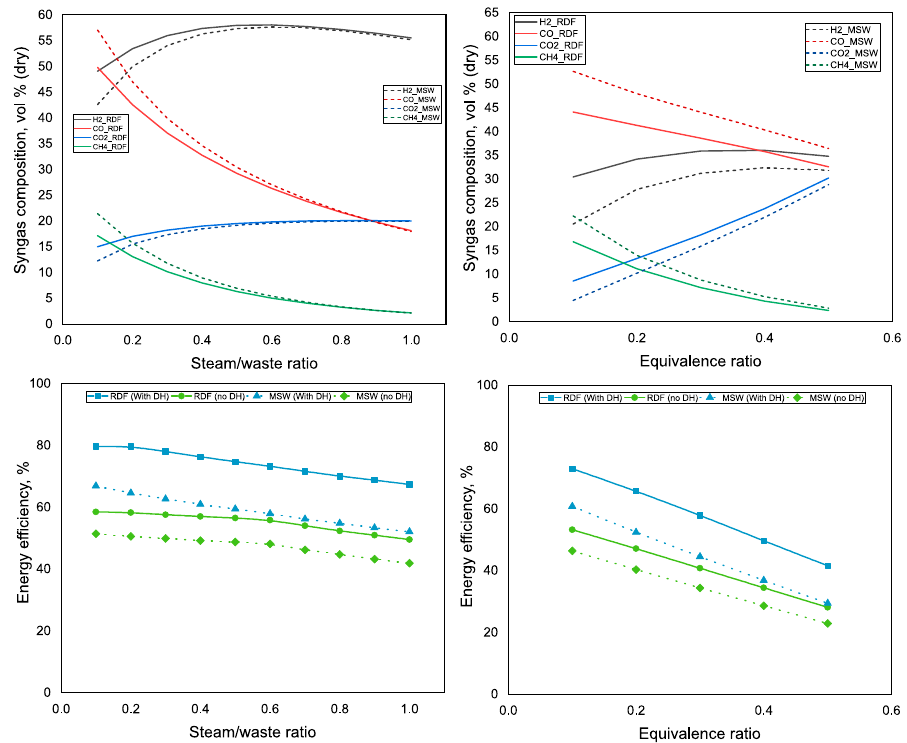
Figure 12. Effect of the steam-to-waste ratio and ER on syngas composition and biofuel synthesis from the CFBG.